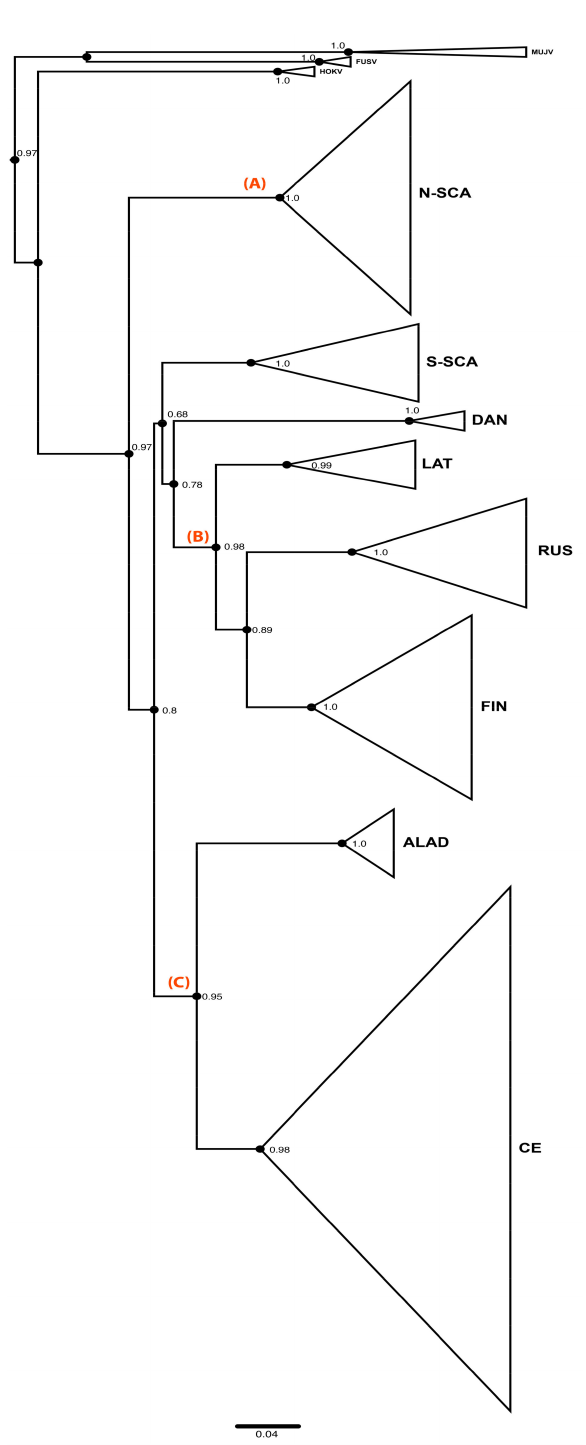
Figure 1. Puumala virus (PUUV) Phylogenetic tree constructed from the complete coding sequence of the small (S) segment by maximum likelihood (ML) method implemented in PhyML 3.0 under the general time reversible (GTR) + G + I substitution model. Branches of the tree clustered within a same PUUV lineage are collapsed to make overall tree visually clear. Eight known PUUV lineages are indicated. The list of sequences belonging to each lineage is indicated in Table S1 together with their geographic origin. Nodes representing most recent common ancestor of North-Scandinavian (N-SCA) lineage, Finnish (FIN), Russian (RUS) and Latvian (LAT) lineages, and Alpe-Adrian (ALAD) and Central European (CE) lineages are indicated, respectively, by the letters A, B, and